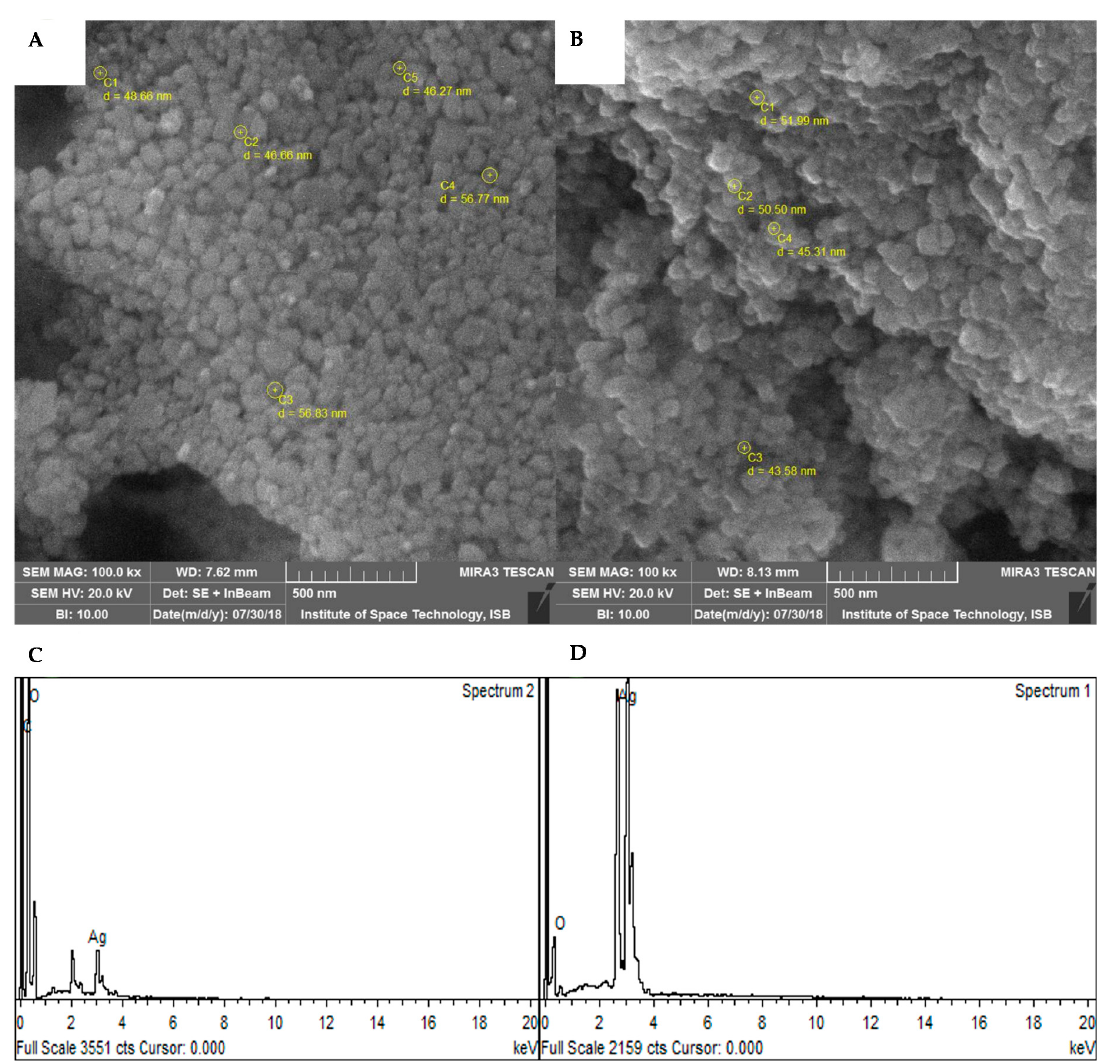
Figure 4 SEM and EDX analysis of AgNPs where ( A ) SEM image of BC-AgNPs ( B ) SEM image of AE- AgNPs ( C ) EDX image of BC-AgNPs ( D ) EDX image of